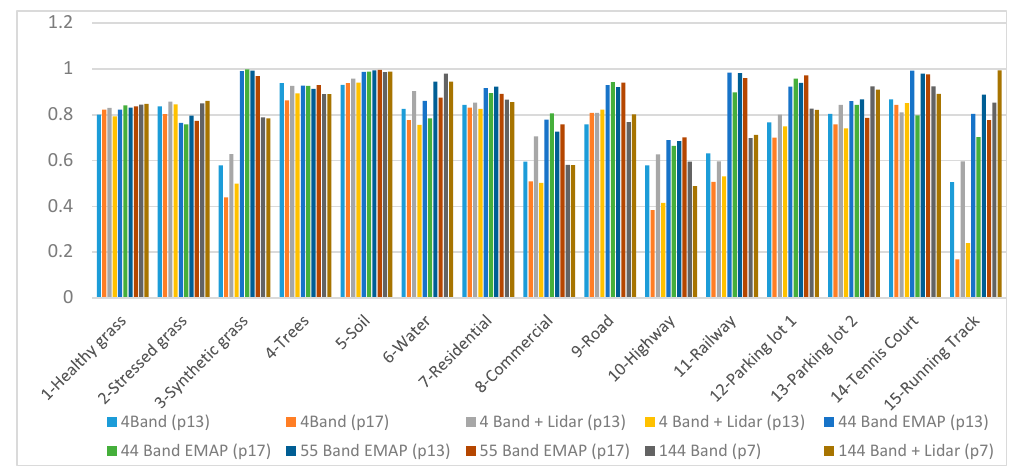
Figure 7. Performance metrics for the investigated band combinations with the CNN-3D model.